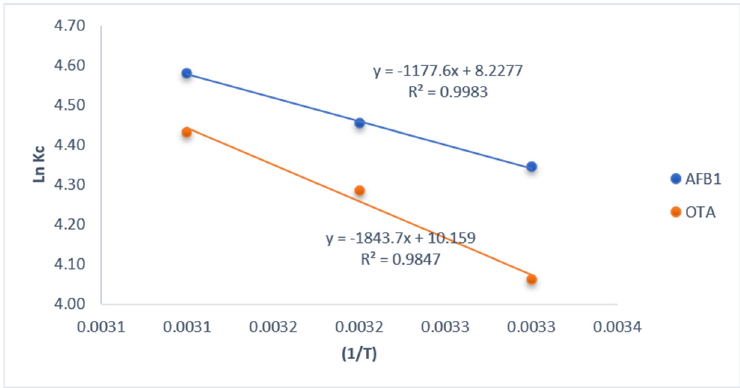
Figure 7. Plots of ln(K c ) vs. 1/T for evaluation of thermodynamic data.